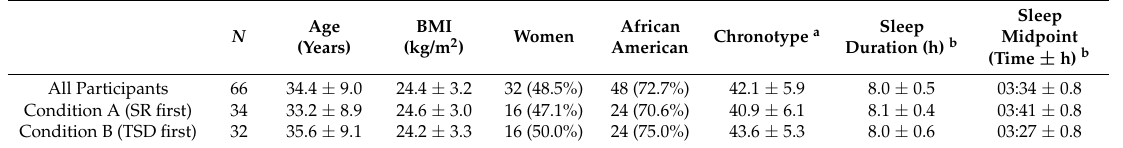
Table 1. Participant characteristics (Mean ±